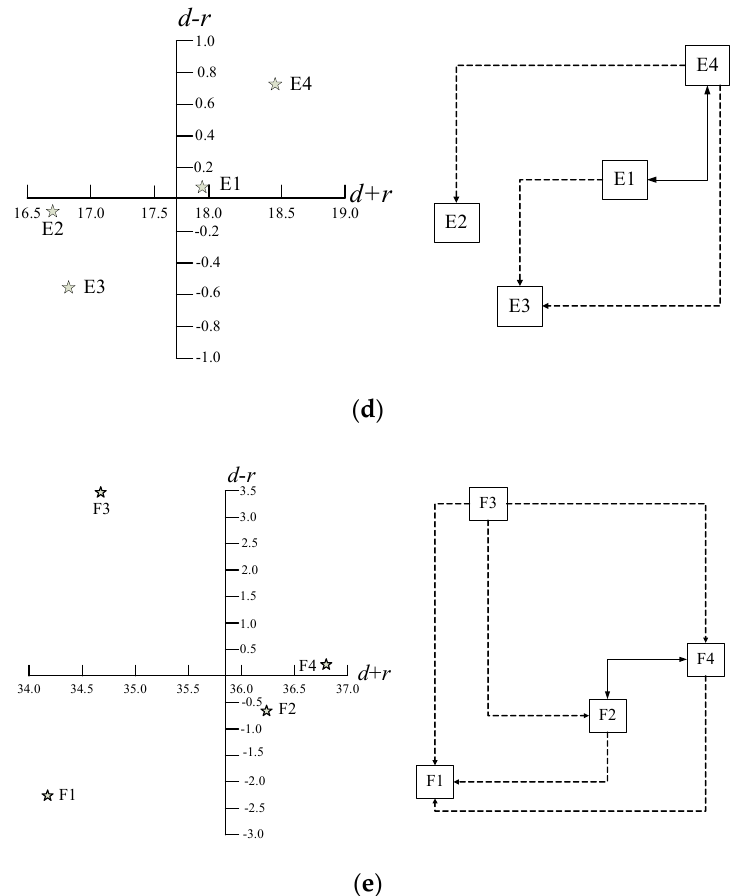
Figure 3. Cause–effect diagram and influence–relations map of indicators under various constructs. ( a ) cause ‐ effect diagram and influence–relations map of operating cost; ( b ) cause ‐ effect diagram and influence–relations map of quality and brand; ( c ) cause ‐ effect diagram and influence–relations map of technology development; ( d ) cause ‐ effect diagram and influence–relations map of product integrity; ( e ) cause ‐ effect diagram and influence–relations map of customer satisfaction.